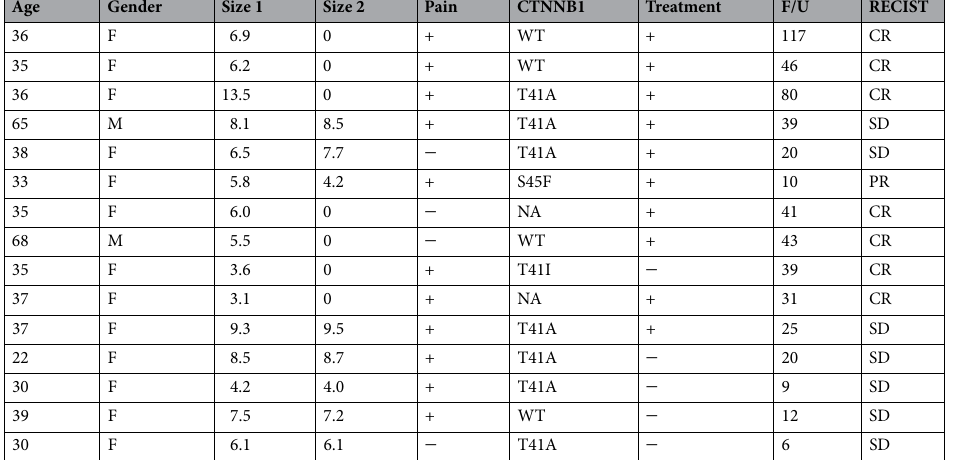
Table 2. Patients with treatment of only active surveillance. Age age at first visit to our hospital, Size 1 maximum tumor diameter at first visit (cm), Size 2 maximum tumor diameter at last visit (cm), Treatment meloxicam or celecoxib treatment at pre-referral or our hospital, F/U follow up duration (months), RECIST evaluation between first and last visit, NA not available due to the poor quality of DNA from desmoid (pre- referral hospital), CR complete remission, PR partial remission, SD stable disease.